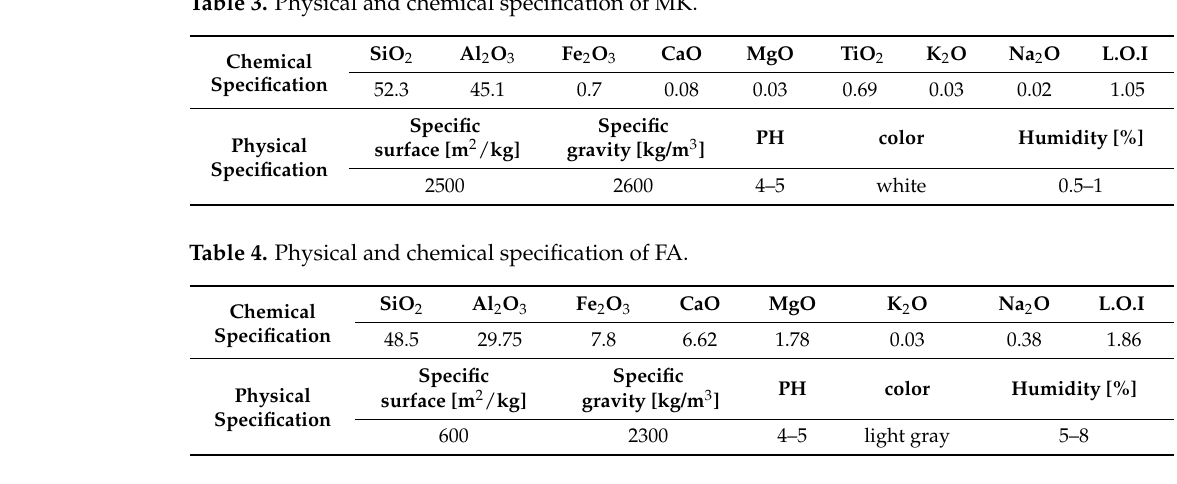
Table 5. Physical and chemical specification of